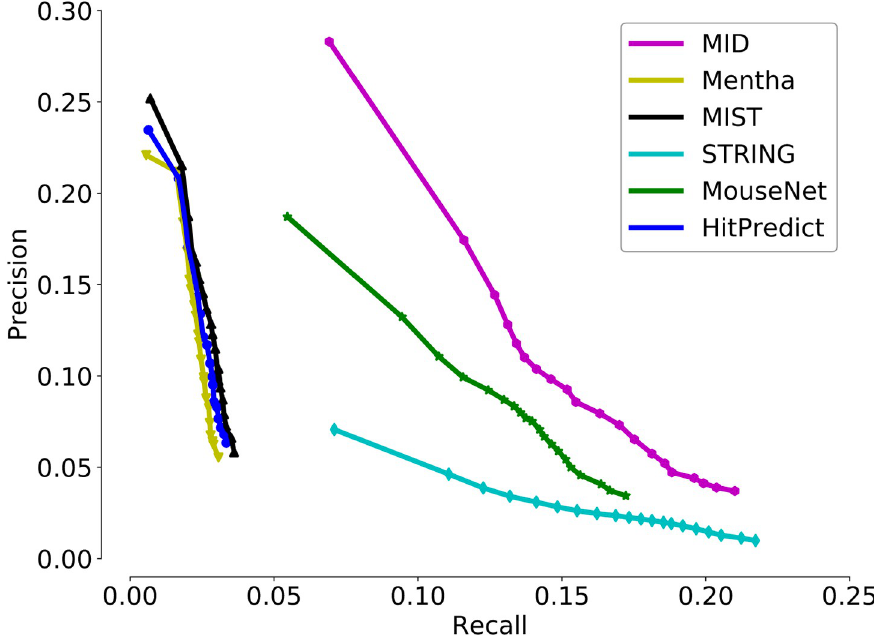
Fig 2. Quality assessment of six interactomes. To assess the quality of our predicted functional association network, MID, we evaluated how well it groups functionally related genes together. Precision measures the fraction of correct annotations predicted using an interactome, while recall measures the fraction of new annotations successfully predicted using an interactome.